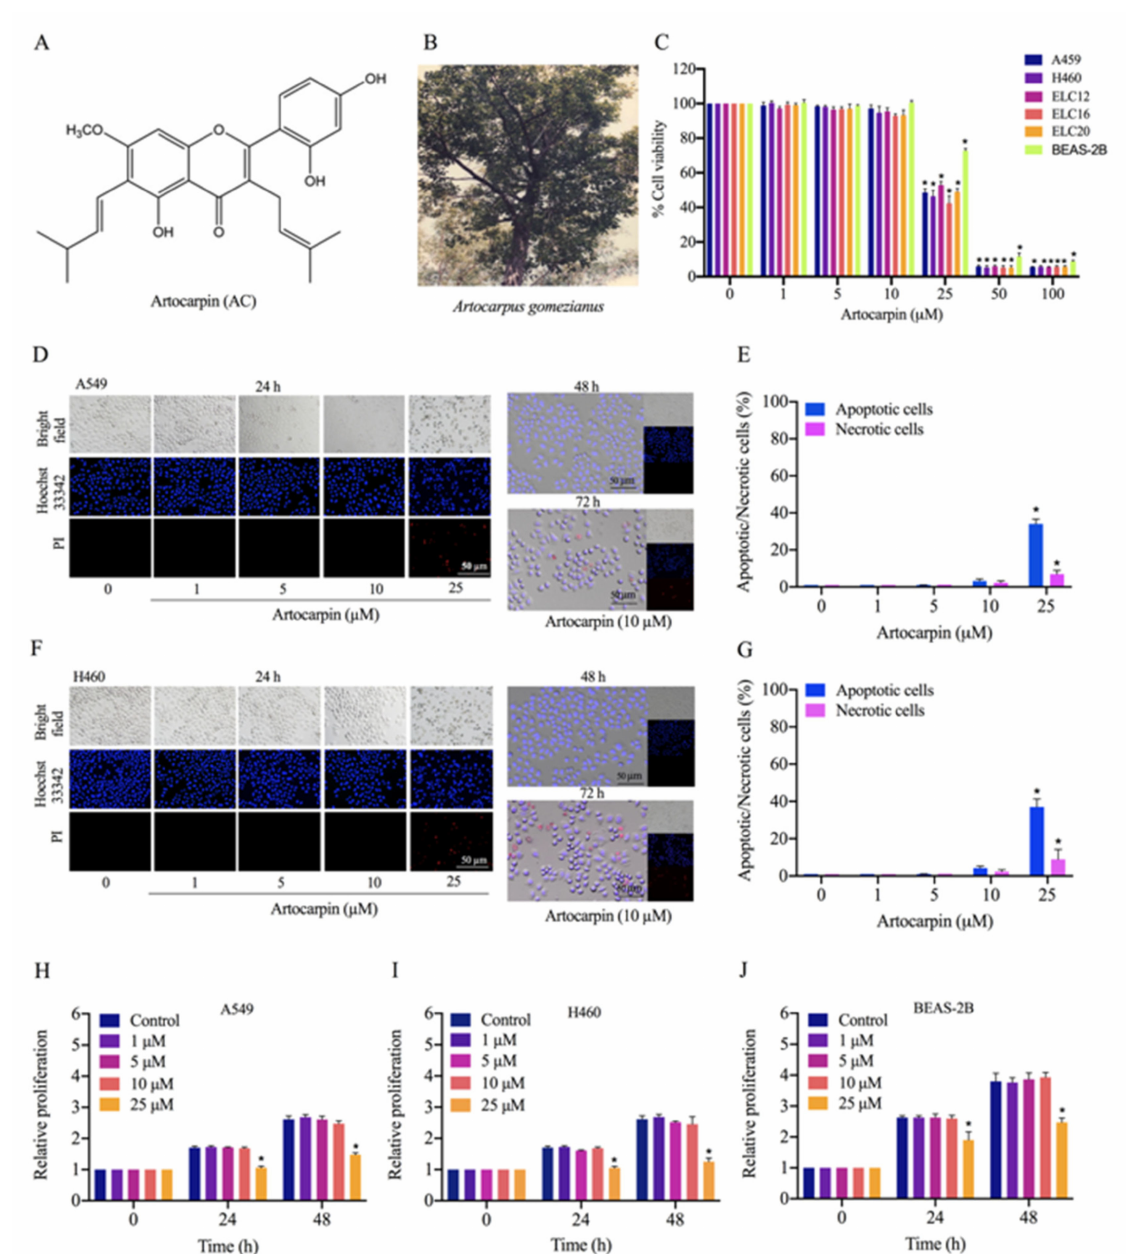
Figure 1. Cytotoxicity of artocarpin on A549, H460, ELC12, ELC16, ELC20, and BEAS-2B cells. ( A ) Chemical structure of artocarpin. ( B ) The whole plant of A. gomezianus . ( C ) Cytotoxic effect of artocarpin on A549, H460, ELC12, ELC16, and ELC20 cells. The cells were treated with several doses of artocarpin (0–100 µ M) for 24 h; cell viability was measured by MTT assay. The percentage of cell viability was calculated relative to the control group. ( D – G ) Apoptotic and necrotic A549 and H460 cells were detected by Hoechst 33342/PI staining and visualized by fluorescence microscopy. Percentage of apoptotic/necrotic nuclei in artocarpin-treated cells was analyzed. ( H – J ) The proliferative effect of artocarpin on A549, H460, and BEAS-2B cells was analyzed by MTT assay. Scale bar represents 50 µ m. The data are presented as the mean ± SD ( n = 3). * p < 0.05 versus the non-treated